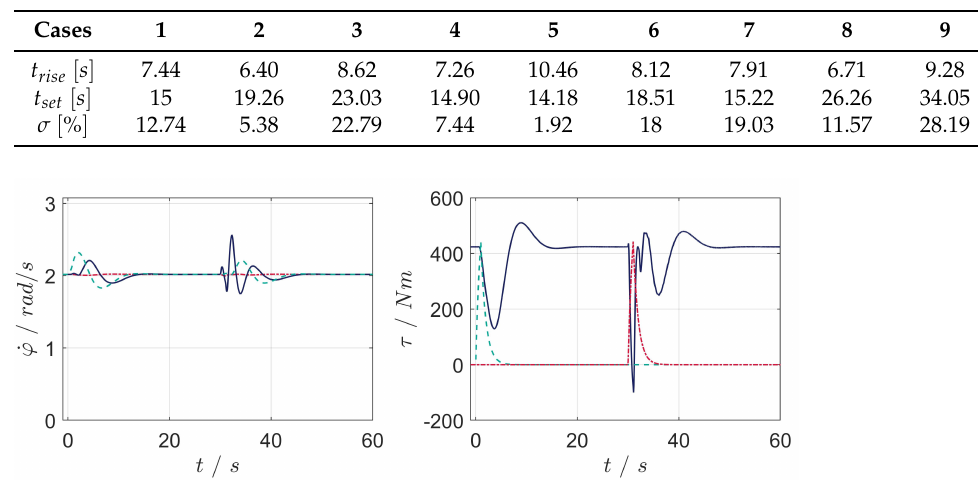
Table 3. Performance measures for ˙ ϕ L .